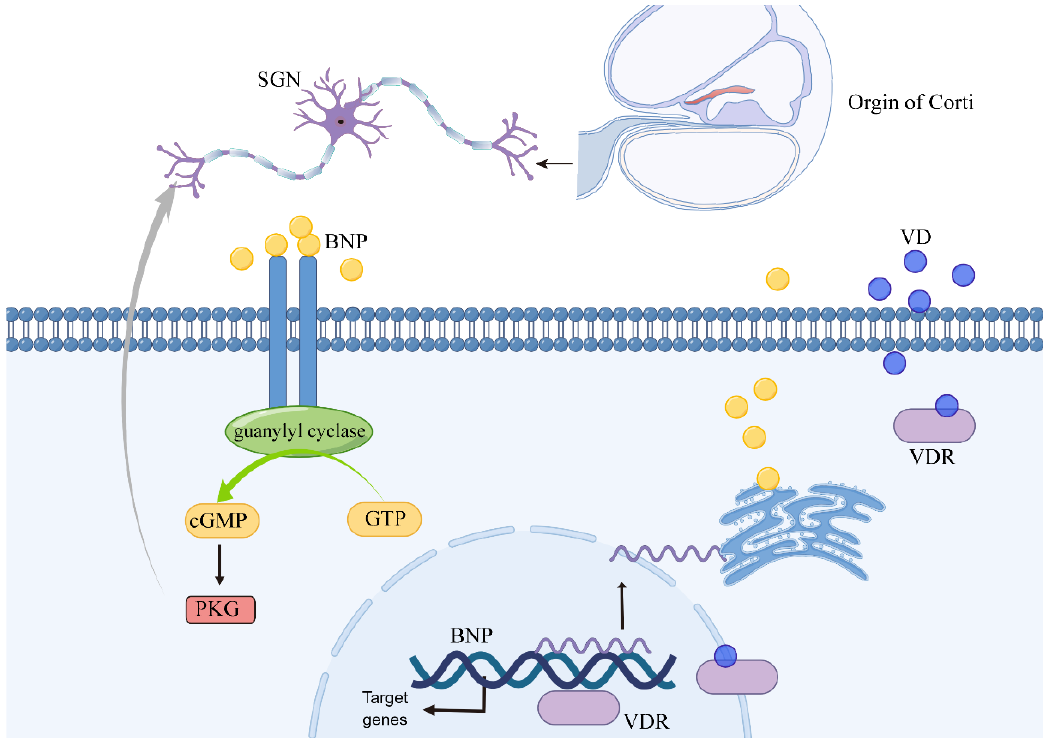
Figure 8. Schematic overview of the role of VDR-BNP in promoting neurite growth and survival of SGNs. Crossing the cell membrane and binding to VDR, VD promotes VDR translocation to the nucleus. In the nucleus, VDR positively regulates BNP expression by binding to BNP gene promoter. Then, BNP plays a neuroprotective role by binding to NPRA, activating guanylyl cyclase and increasing the level of the second messenger (cGMP), then activating cGMP-dependent protein kinase G.